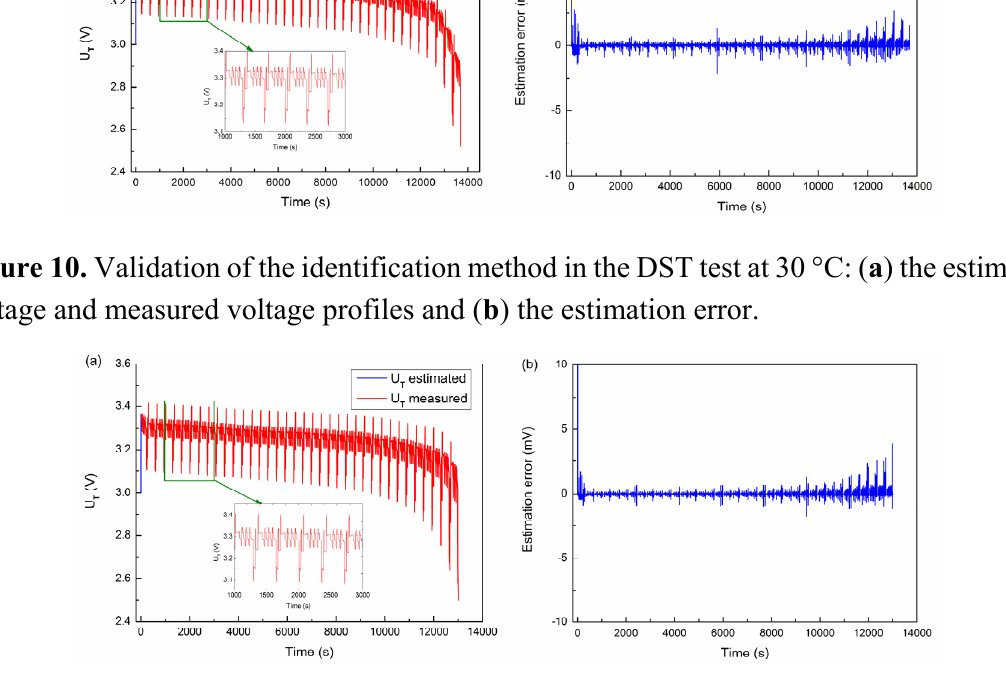
Figure 11. Validation of the identification method in the DST test at 20 °C: ( a ) the estimated voltage and measured voltage profiles and ( b ) the estimation error.